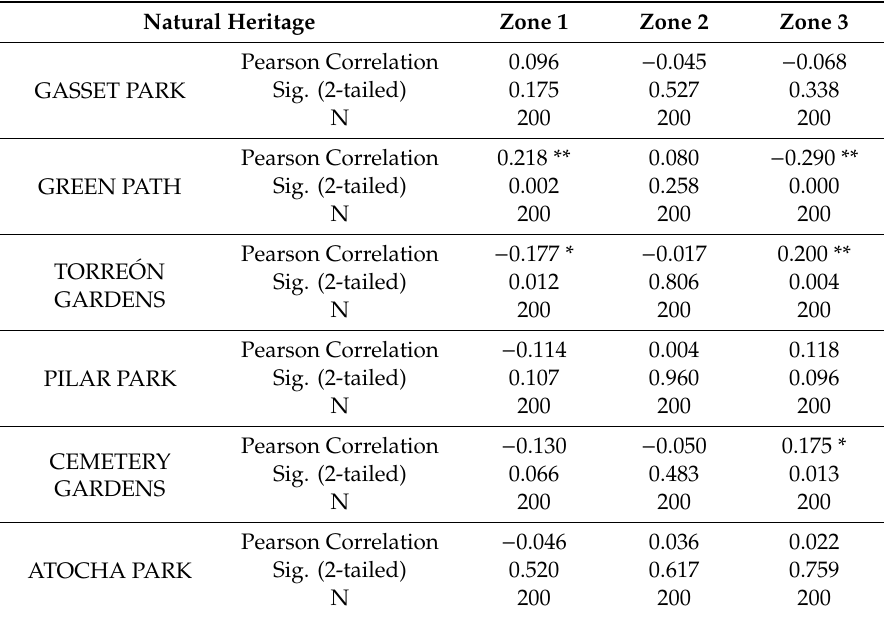
Table 3. Results of answers related to natural